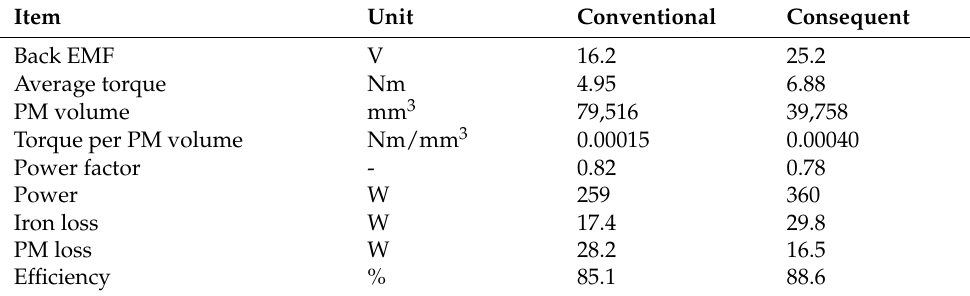
Table 5. FEM analysis